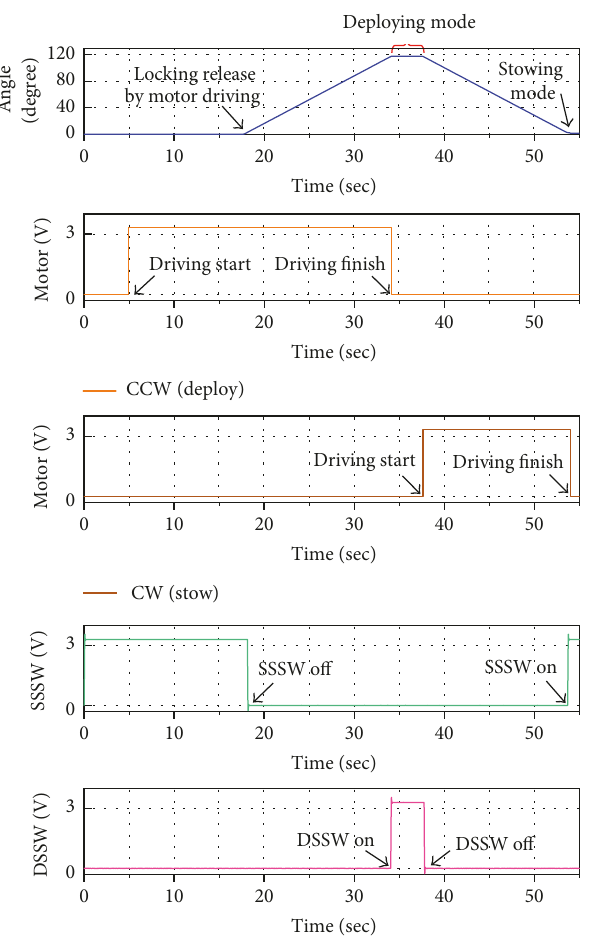
Figure7:Timehistoriesobtainedfromthelaunchlockingreleasing, stowing, and deploying function tests.